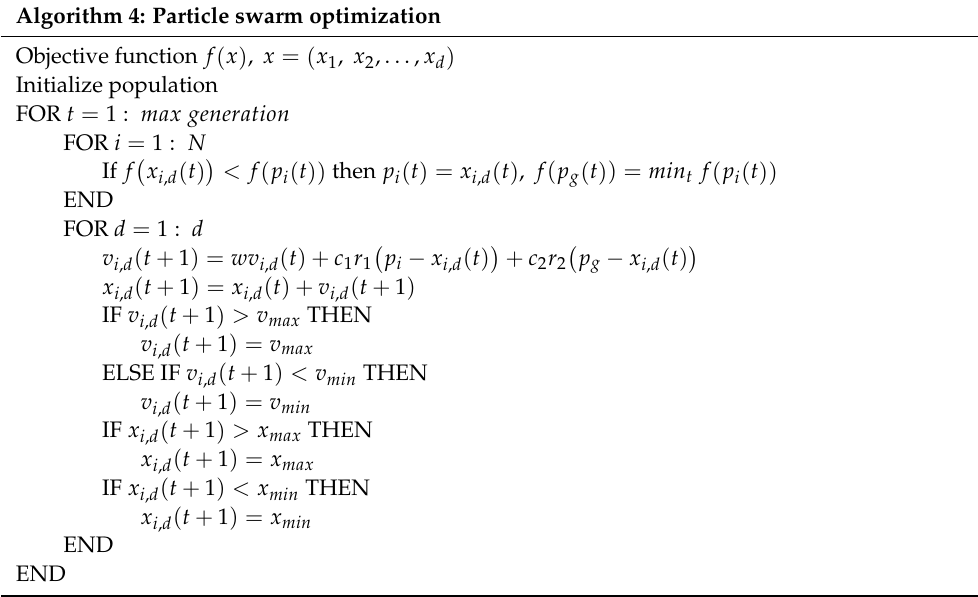
Algorithm 4: Particle swarm